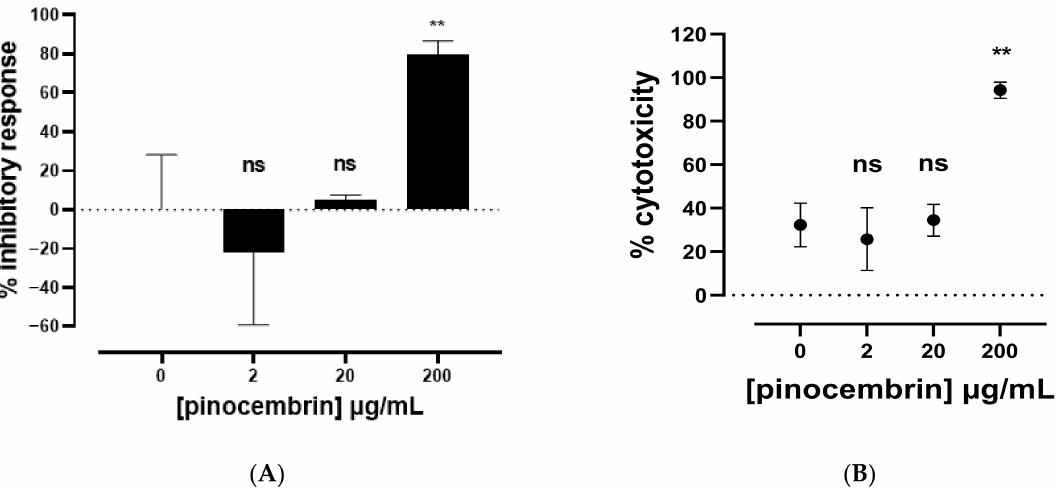
Figure 3. ( A ) Anti-inflammatory activity. Nitrite representative of NO production was quantified using Griess reagent, and percent of the inhibitory response was calculated compared to the level of LPS-dependent nitrite production; ( B ) cytotoxicity of pinocembrin (PC) on LPS-induced RAW264.7. Murine macrophages RAW264.7 (150,000 cells/well in P96) were treated with LPS ( E. coli 0111:B4) at 1 µ g/mL and pinocembrin at 2, 20, and 200 µ g/mL for 24 h. Cytotoxicity was measured by quantification of LDH production. Results are means ± SD (at least n = 3 well replicates). Mann– Whitney test was used to compare LPS and molecule treatments. ns, nonsignificant; **, p <